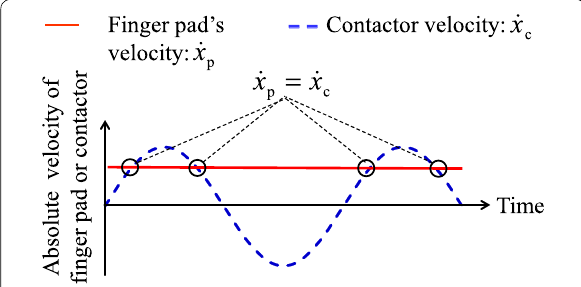
Fig. 2 Velocities of finger and vibrating contactor. The contactor ( dotted line ) sinusoidally vibrates whereas the finger velocity ( solid ) is constant. At those points at which ˙ x p − ˙ x c becomes zero, static friction